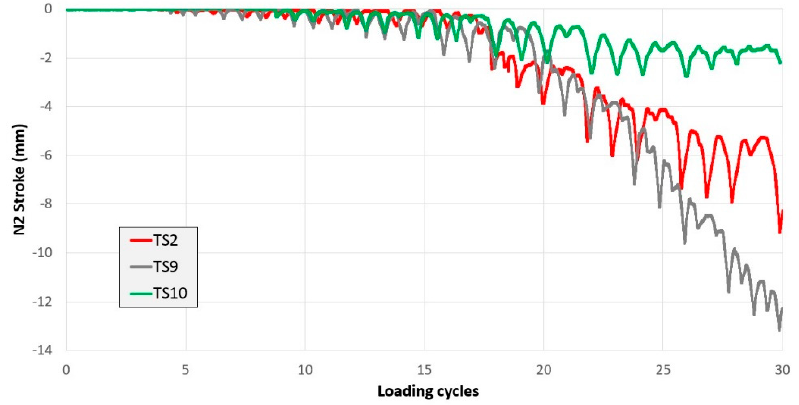
Figure 10. Stroke of N2 transducer versus number of loading cycles.